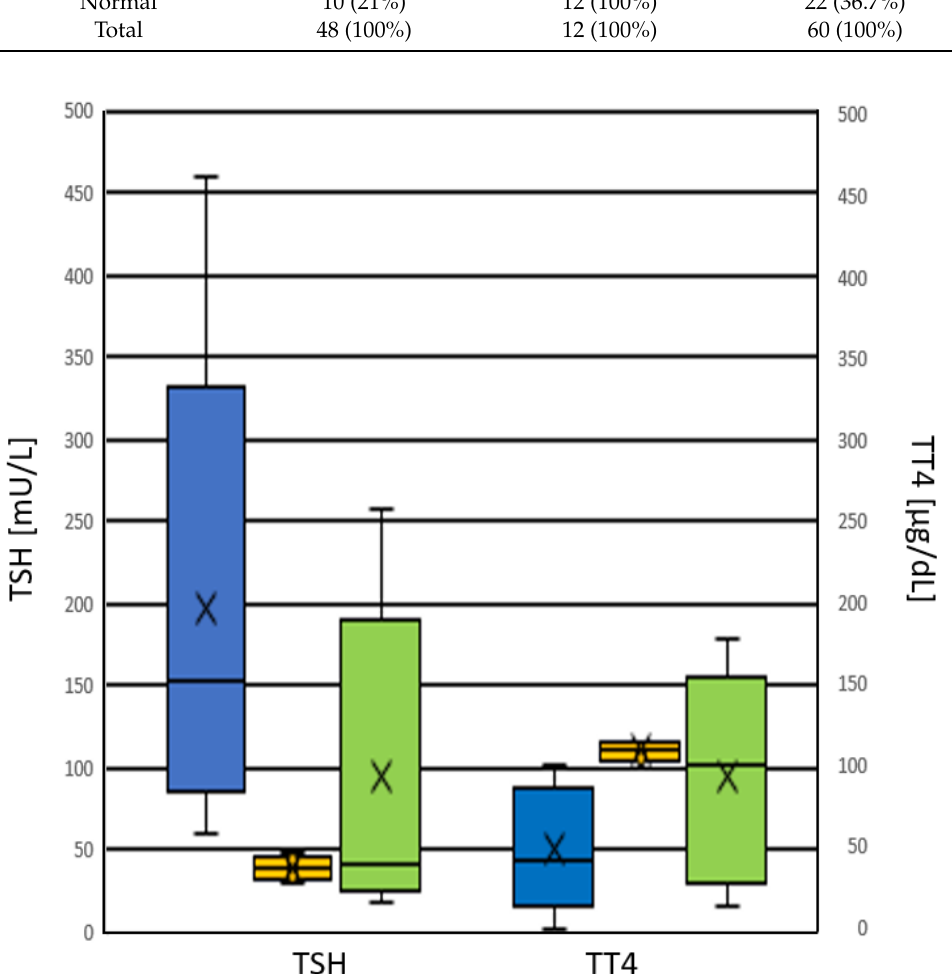
Figure 9. Correlation between thyroid sonography and TSH and TT4, respectively. ■ Athyreosis/ektopia, ■ hypoplasia, ■ normal.